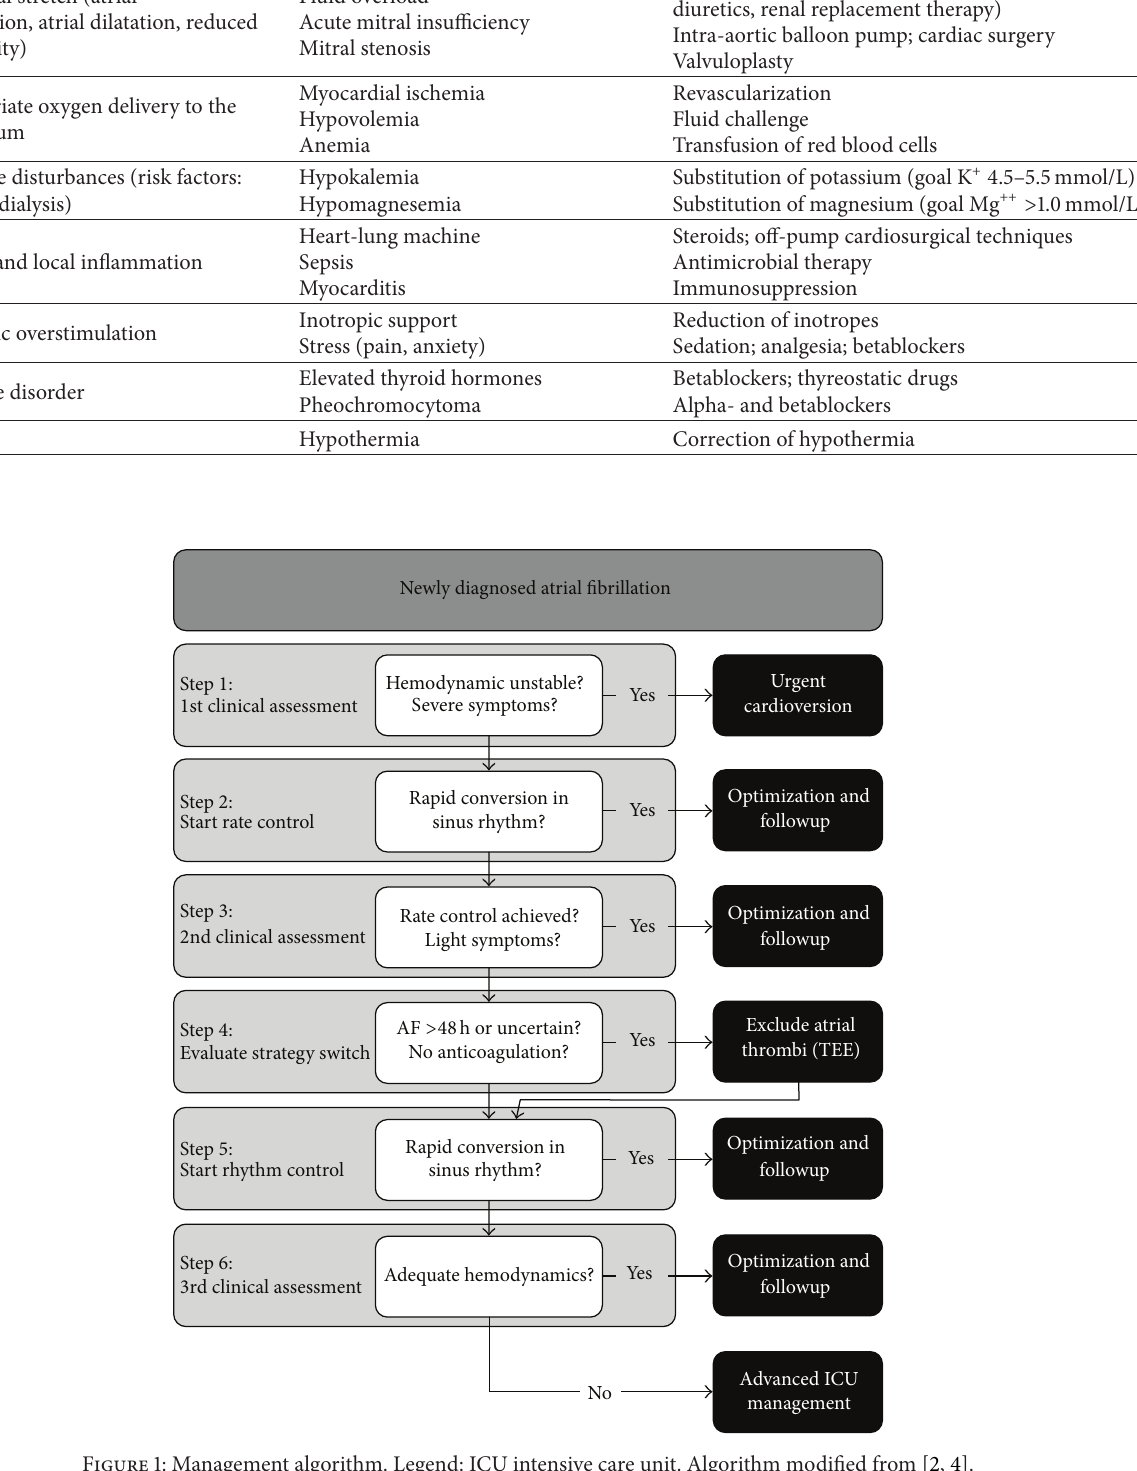
Figure 1: Management algorithm. Legend: ICU intensive care unit. Algorithm modified from [2,